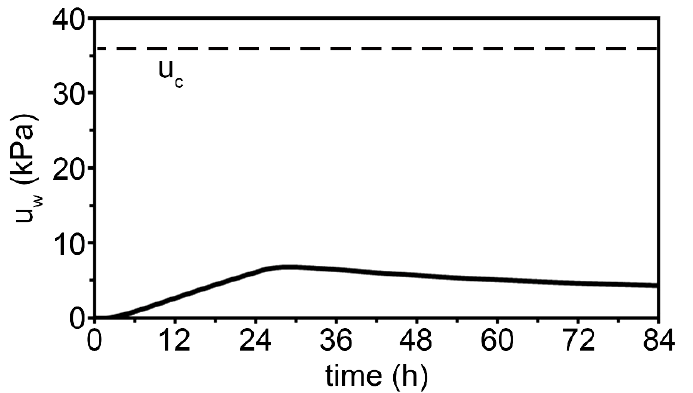
Figure 17. Evolution of the change in pore water pressure, w u , with time due to the rainfall of 10 April 2005, with indication of the critical threshold, c u , at the depth of 1.40 m.